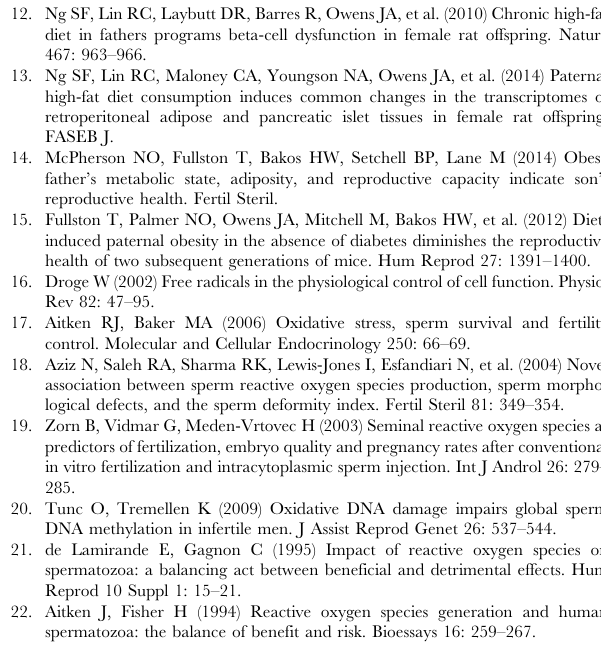
Table S1 Female offspring body composition assessed by DEXA at 4, 8 and 14 weeks of